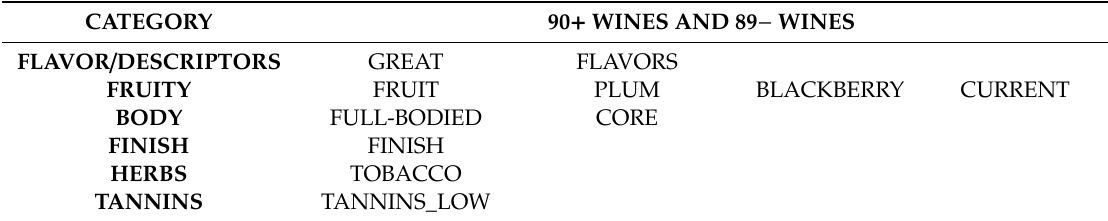
Table 3. Common keywords between 90+ and 89 − wines from ALL Bordeaux Wine dataset. 90+ WINES AND 89 − WINES